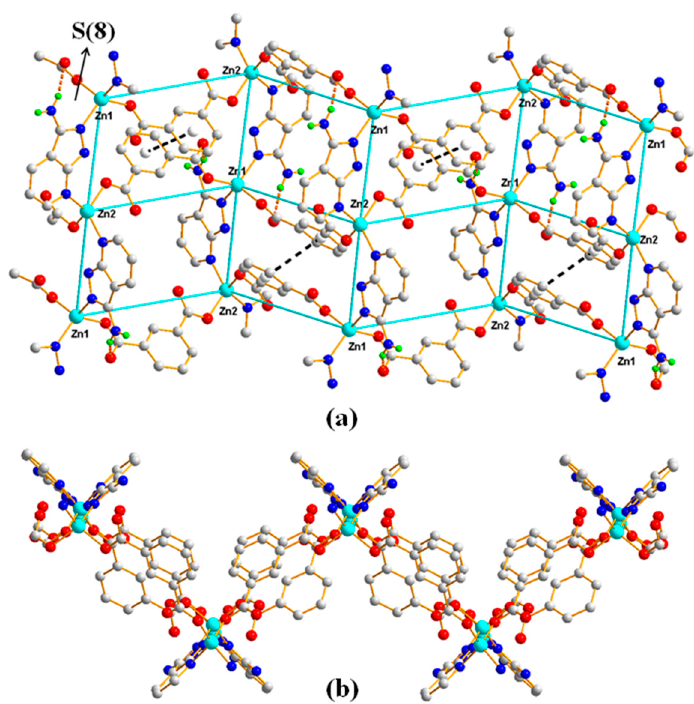
Figure 3. ( a ) The 2D structure of Polymer 1 with the 4-connected sql net highlighted. The dotted lines depict the noncovalent interactions (brown: hydrogen-bonding interactions; black: π – π -stacking interactions) and ( b ) the view down the a -axis of the 2D structure.